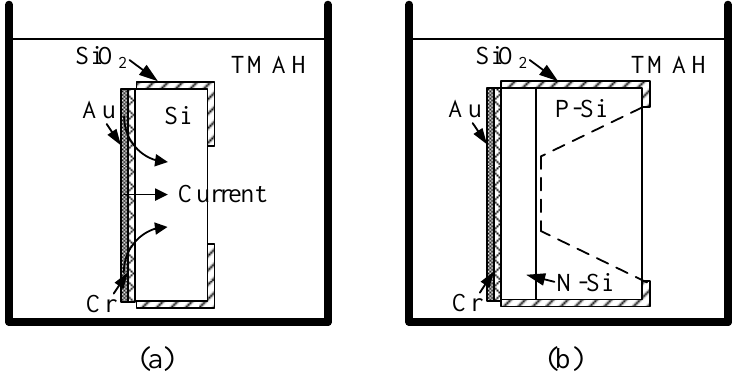
Figure 1. Principle and set-up of the galvanic etch stop. (a) Au, Si and TMAH form a galvanic cell. (b) pn junction galvanic etch